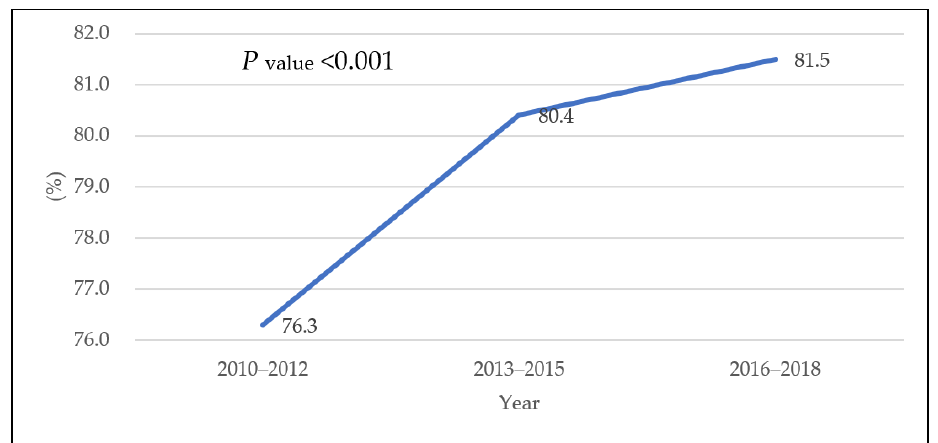
Figure 2. Trends in the prevalence of breastfeeding among women aged 19–49 years from 2010 to 2018. Table 1. Trends in the prevalence of breastfeeding among women aged 19–49 years from 2010 to 2018 in subgroups.